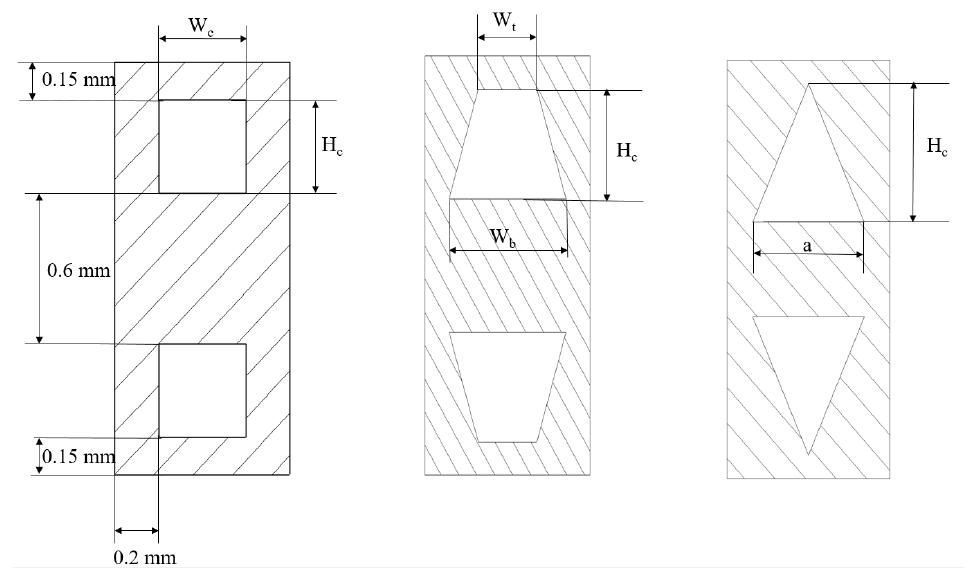
Figure 2. Different cross-sectional shapes of microchannels and their dimensional parameters.